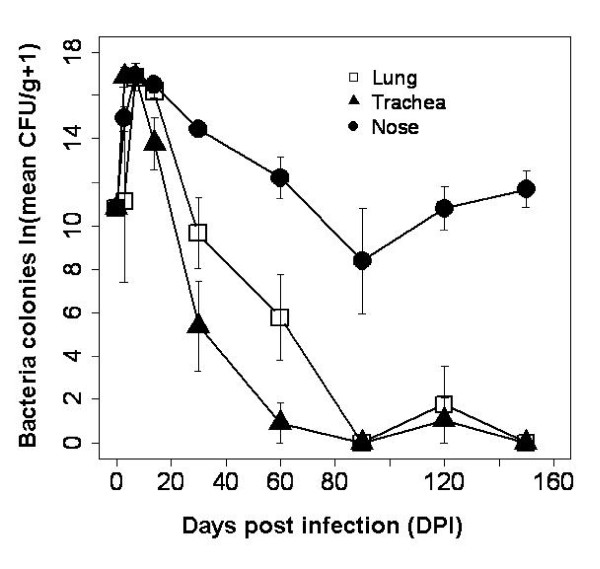
Mean number of bacteria (CFUs/g ± S.E.) in the respiratory tract of infected rabbits at days 3, 7, 14, 30, 60, 90, 120 and 150 post-infection (DPI). Initial infection dose is reported (Day 0 = log(50,000 CFU/ml+1)). At each day post infection, lungs, trachea and nasal cavity were collected from 4 infected and 2 control rabbits and individually stored in PBS. Serial dilutions of the homogenates were plated out on BG blood agar plates supplemented with streptomycin. Bacteria were enumerated after incubating for 36-48hr at 37°C. The number of bacteria significantly declined with infection time (LME, DPI: P < 0.0001) and was significantly higher in the nares than trachea or lungs (LME, Organs: P < 0.0001).